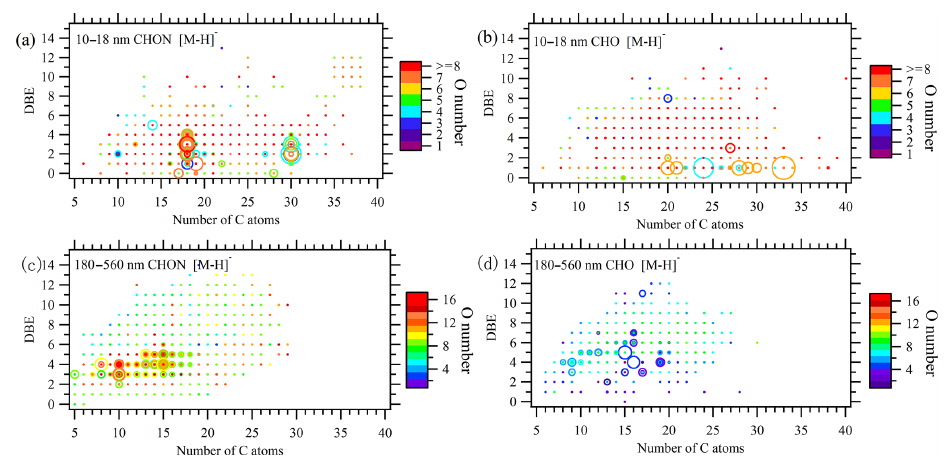
Figure 2. DBE vs. C atom number diagrams of all CHON and CHO formulas detected in 10–18 and 180–560nm particles in ESI − mode. The color bar denotes O atom number in the formulas. The size of the circles reflects the relative intensities of molecular formulas on a logarithmic scale.